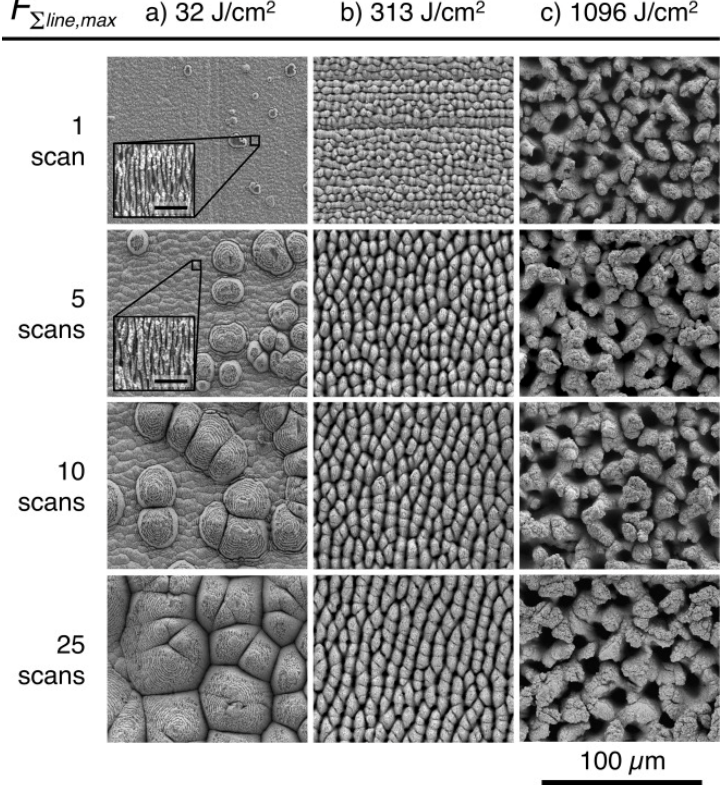
Figure 17. Evolution of micro/nano periodic surface structure with cumulative energy densities and scan times. ( a ) Ellipsoidal cones; ( b ) Columnar structures; ( c ) Chaotic structures. “Reprinted with permission from Ref. [60], Copyright (2015), Elsevier”.